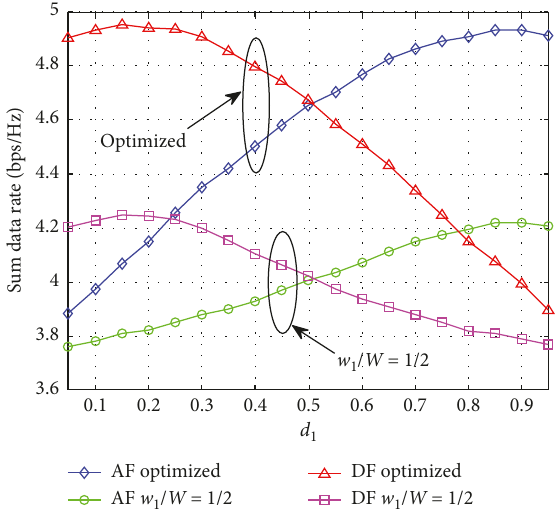
Figure 3: Sum data rate vs. distance d R / W � 1/2 bps/Hz, and P � th